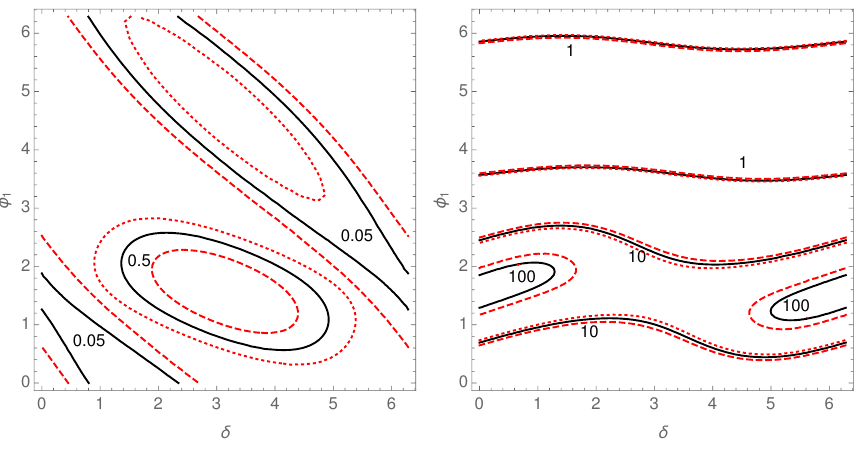
2 = 2 as a function of the two CP phases (cid:14); (cid:30) U ei U (cid:22)i j j j j [ 1 ; (cid:11) 2 (cid:0)